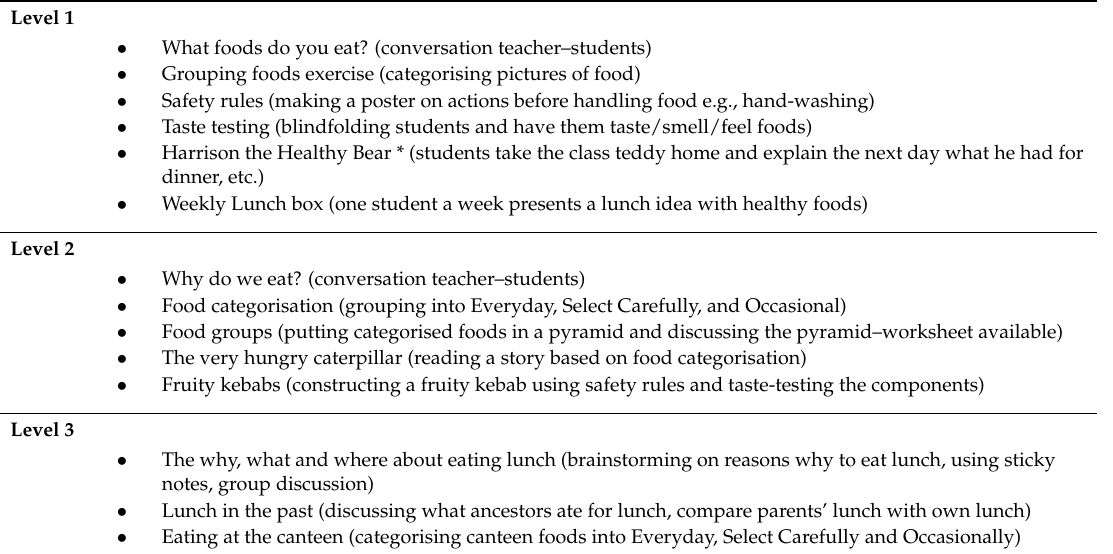
Table 3. Several examples of nutrition education from the “Healthy Canteen Kit—Student Learning Activities”